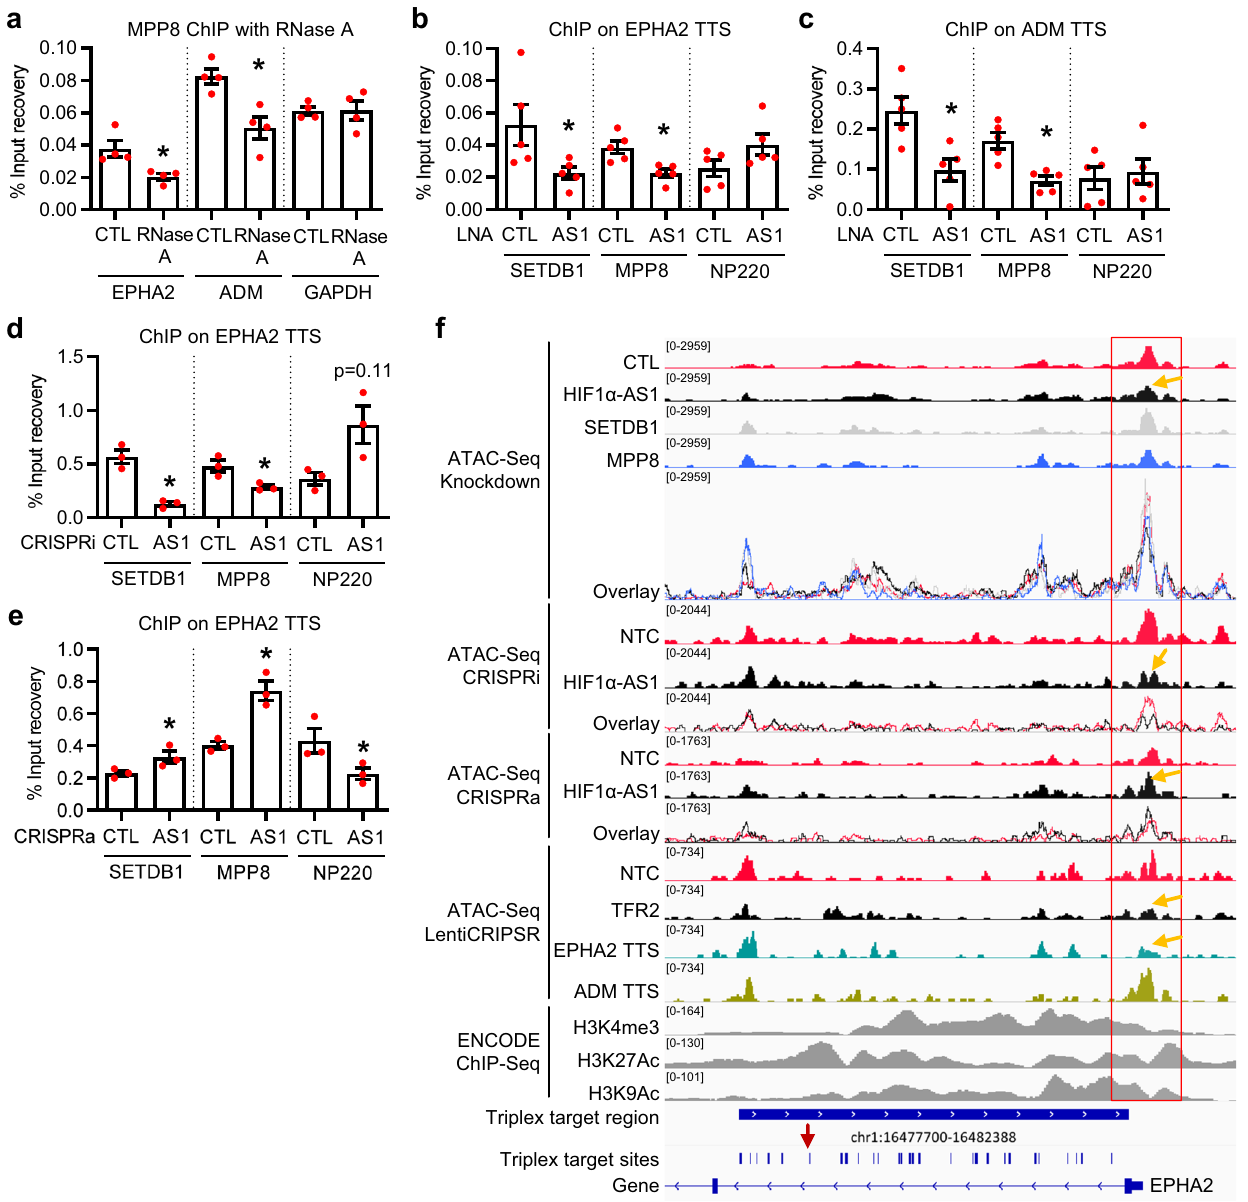
Fig. 6 | HIF1 α -AS1 directs the HUSH complex member MPP8 and SETDB1 to triplex target sites. a Chromatin immunoprecipitation (ChIP) with MPP8 anti- bodies with or without RNase A treatment and qPCR for the triplex target sites of EPHA2 and ADM . Primers against a promoter sequence of GAPDH served as nega- tive control. n =4 independent experiments, paired t test. *EPHA2 ( p =0.0223), *ADM ( p =0.0221). b , c ChIP with antibodies against SETDB1, MPP8 or NP220 in HUVECstreatedwith(AS1)orwithout(CTL)LNAGapmeRsagainst HIF1 α -AS1 .QPCR was performed for EPHA2 TTS (b) or ADM TTS (c). n =5 independent experiments, paired t test. b: *SETDB1 ( p =0.0487), *MPP8 ( p =0.0287); c: *SETDB1 ( p =0.0358), *MPP8( p =0.0109). d , e ChIPwithSETDB1,MPP8orNP220antibodiesafterCRISPRi (d) or CRISPRa (e) for HIF1 α -AS1 and qPCR for EPHA2 TTS. n =3 independent